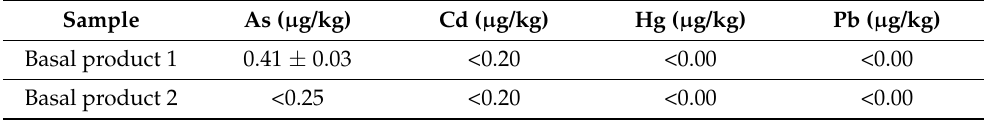
Table 5. Metal content of the bioavailable fraction of product 1, product 2, product 3 and